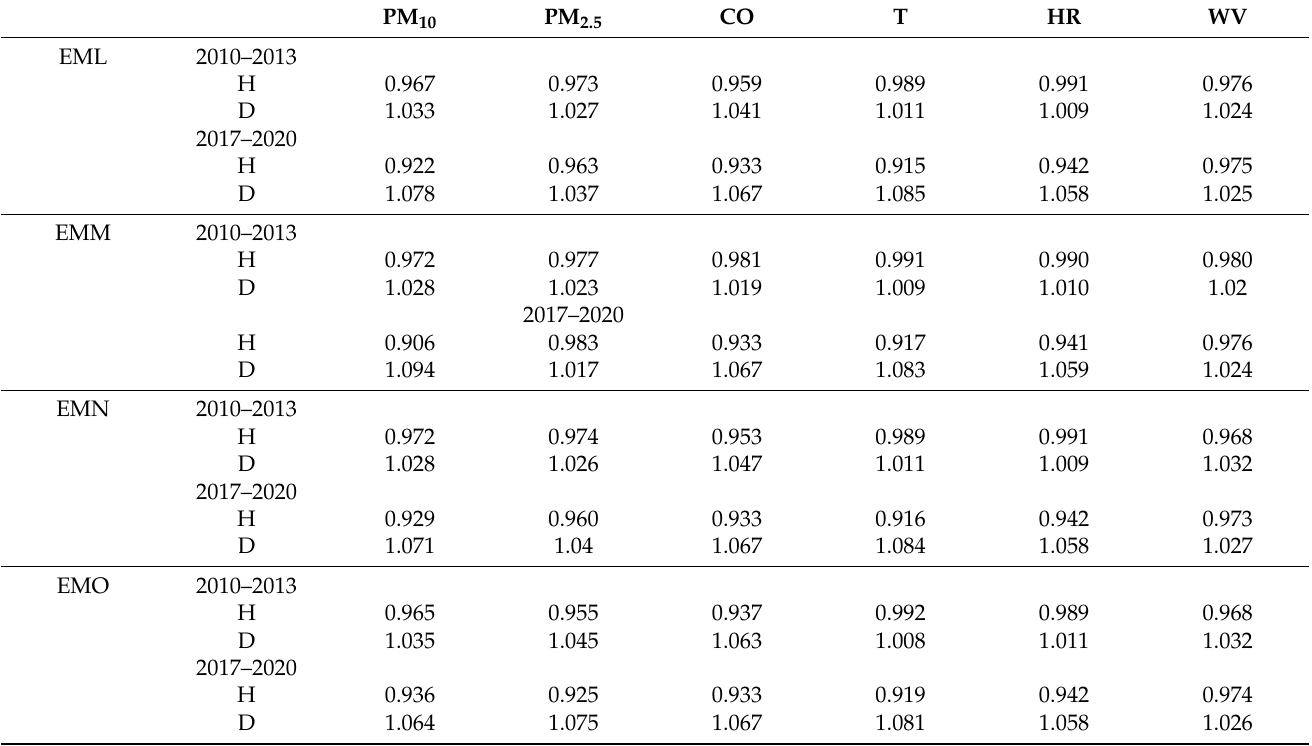
Table A1. All the values of the Hurst exponent (H), the fractal dimension (D) for all the variables